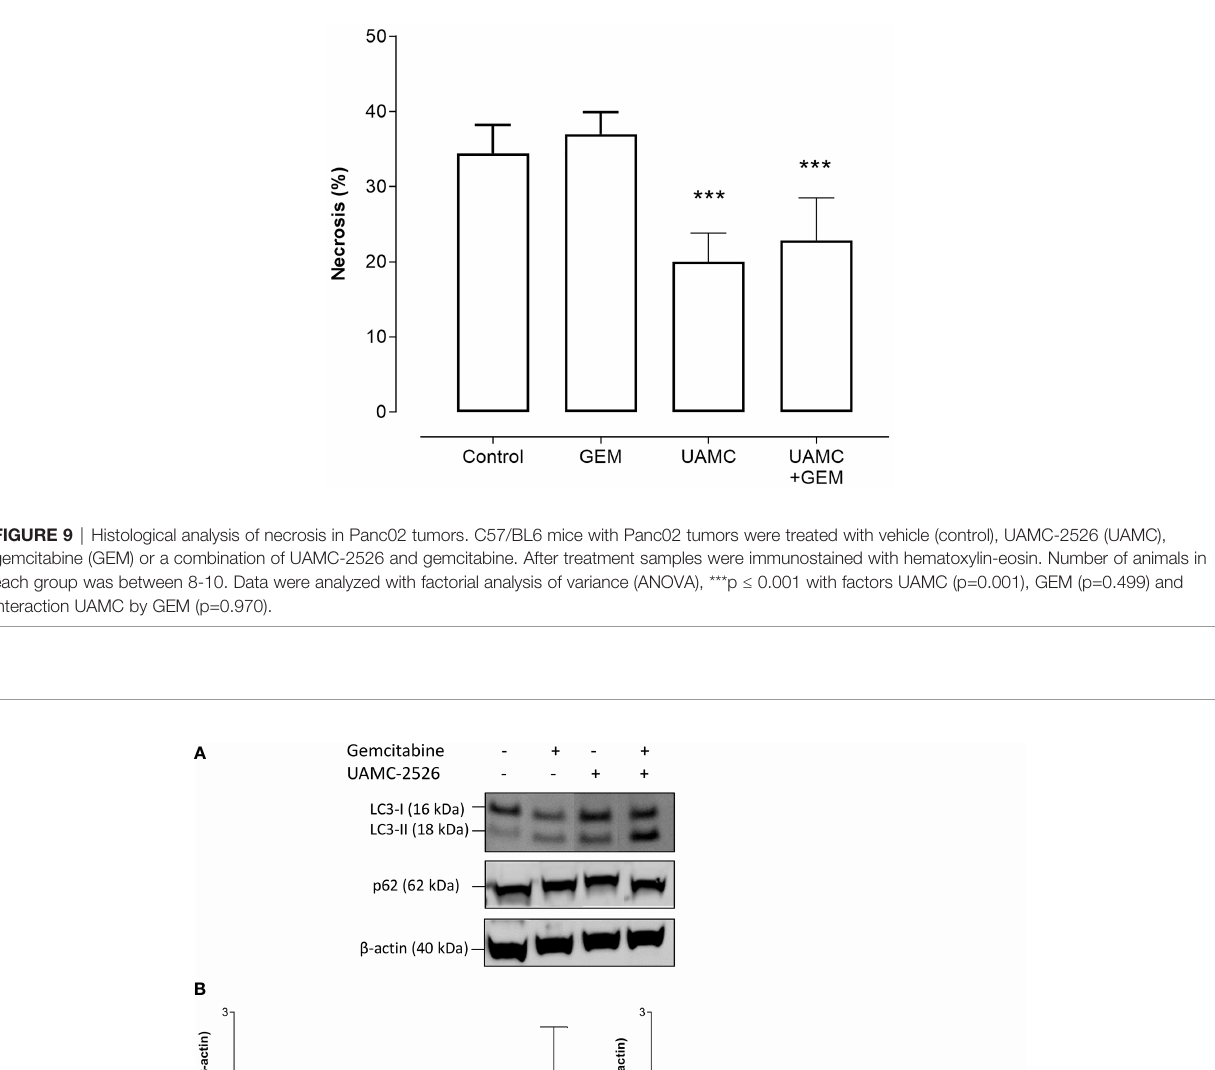
2526. Apoptosis was not affected in Panc02 tumors by both